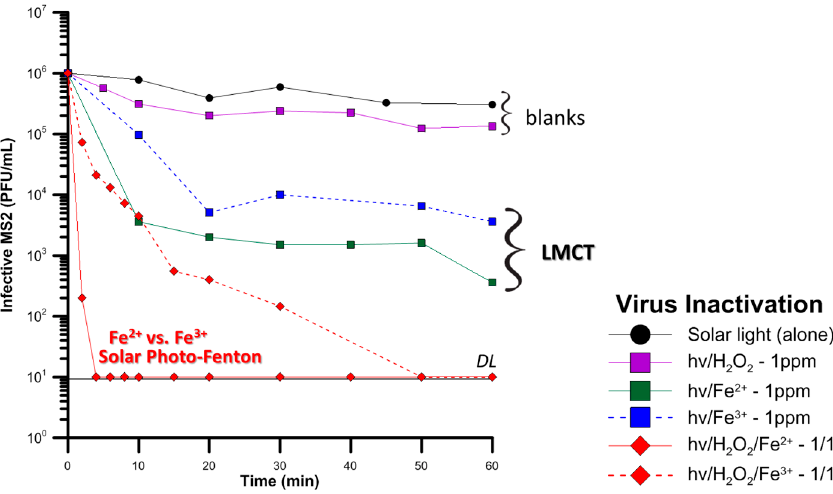
Figure 4. Stepwise construction of the solar photo-Fenton process. Effects of solar light, solar/H 2 O 2 , solar/Fe and solar photo-Fenton in viral (MS2) infectivity in simulated secondary wastewater, as in [87]. Note the difference inflicted by the initial speciation of iron in the solution.